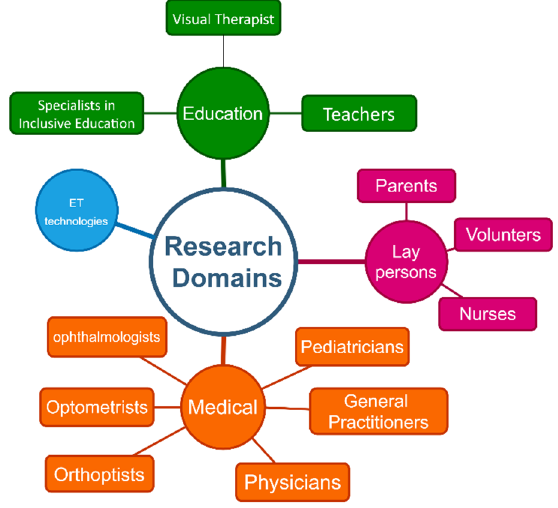
Figure 6. Research domains for further investigation.